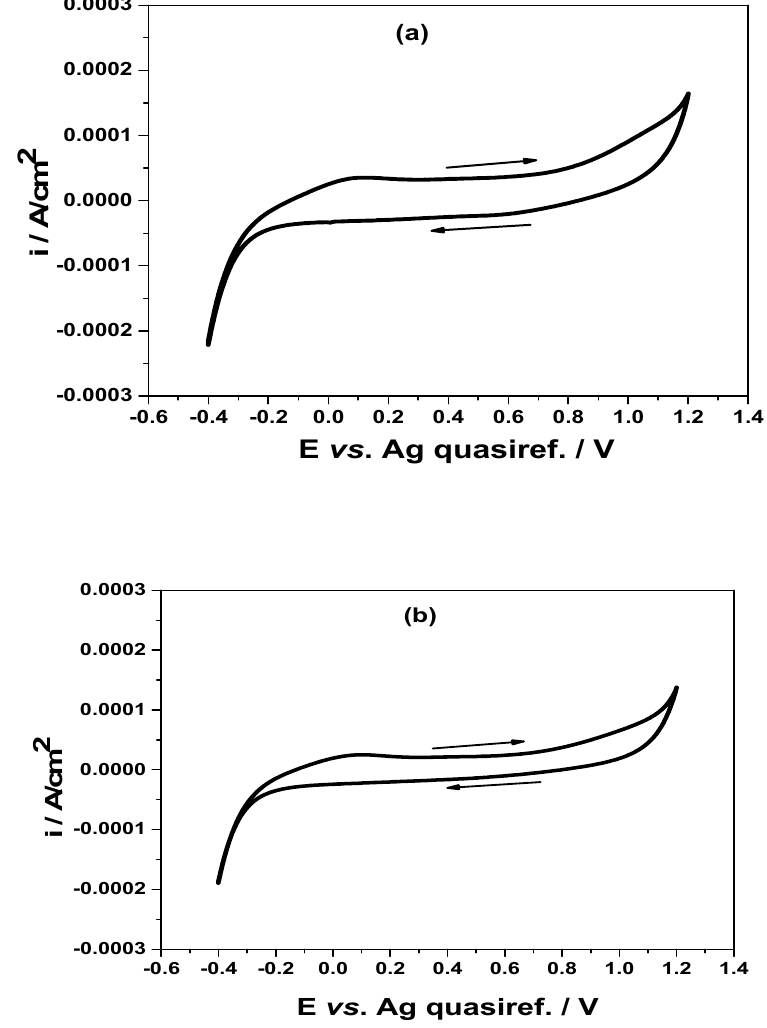
Figure 1. Cyclic voltammograms on NiCr alloys in ILM-ACN electrolyte: ( a ) IB alloy; ( b ) ND alloy. The scan rate was 10 mV s − 1 and T = 25 °C.